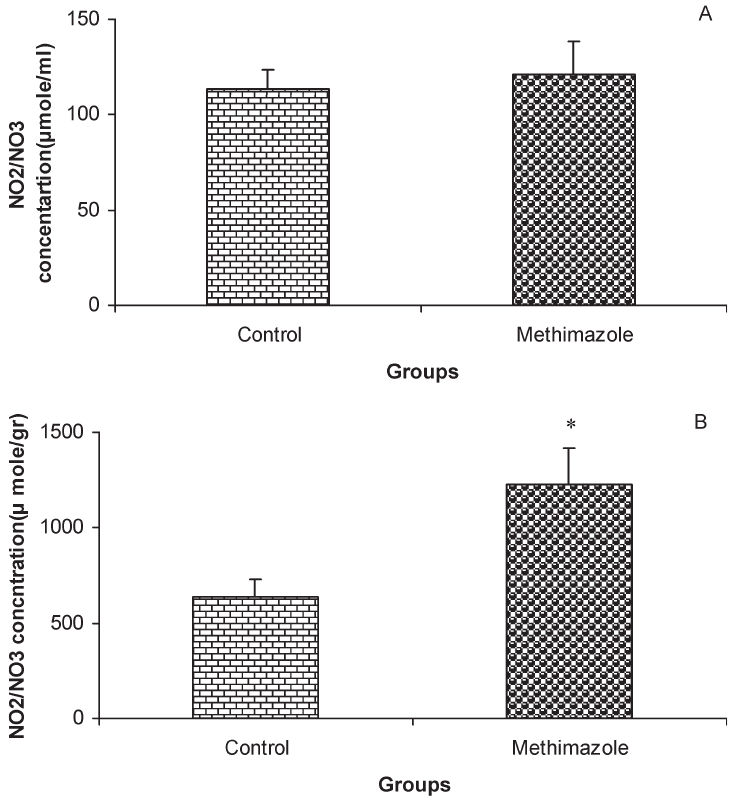
Figure 5 - Comparison of plasma NO metabolite levels ( A ) and the concentrations of these metabolites in hippocampal tissue ( B ) between offspring of the methimazole and control groups. Data are shown as mean ¡ SEM of seven animals per group. There were no significant differences between the plasma concentrations of NO 2 or NO 3 ; however, the concentration of NO metabolites in the hippocampi of the methimazole group offspring was higher than that of the control animals. * P , 0.05 compared